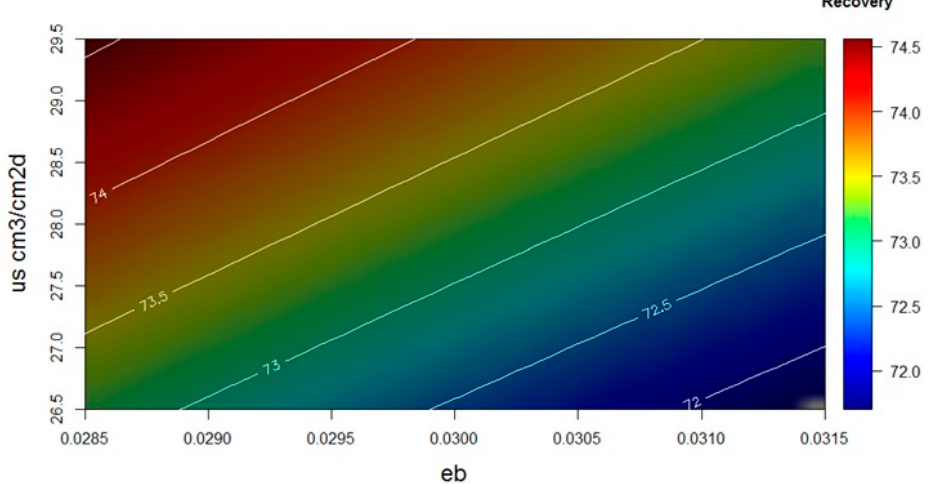
Figure 16. Plane (cid:1852) = 300 cm including both groups (cid:1828) (desired outcome, recovery >73.5%) and (cid:1828)(cid:3364) Figure 16. Plane Z = 300 cm including both groups B (desired outcome, recovery >73.5%) and B (undesired outcome, recovery <73.5%) (undesired outcome, recovery